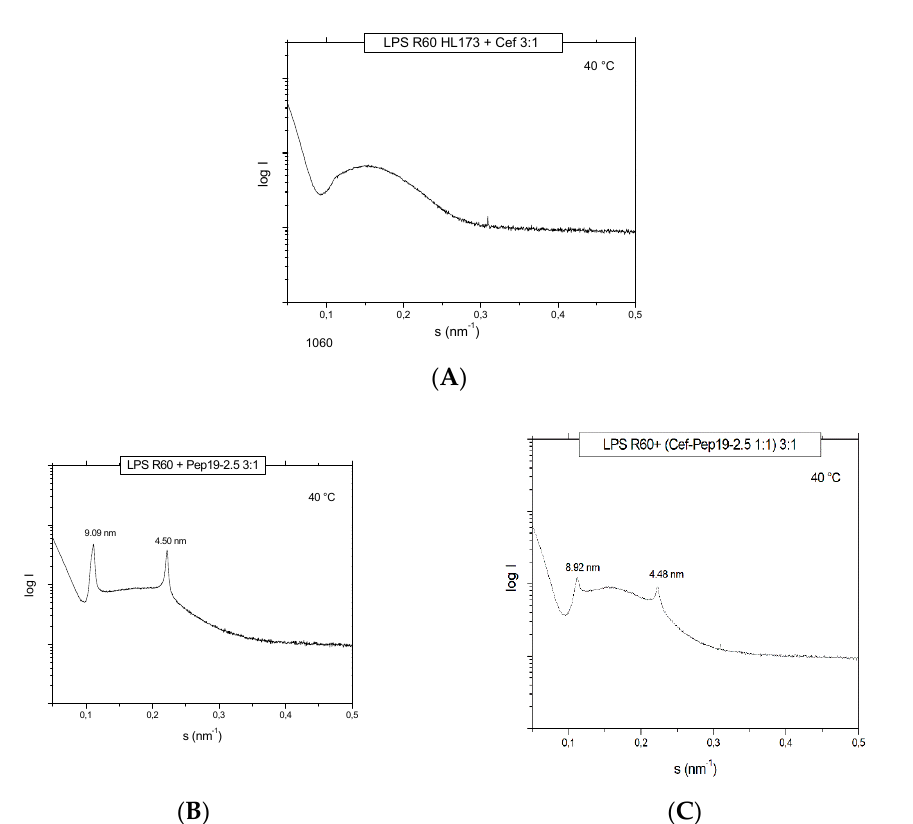
Figure 3. Small-angle X-ray scattering patterns at 40 °C of LPS R60 + ceftriaxone ( A ), LPS + Pep19-2.5 ( B ), and LPS + (Cef+Pep19-2.5 1:1 weight %) ( C ). Presented is the logarithm of the scattering intensity log I versus the scattering vector s (= 1/d, d spacings of the reflections).